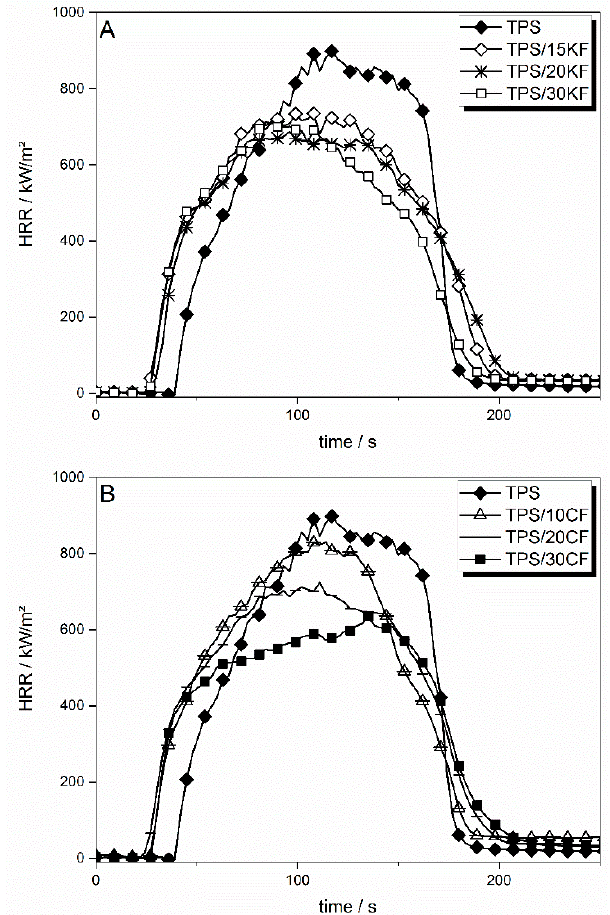
Figure 11. HRR curves for TPS reinforced with different amounts of keratin ( A ) and coconut fibres ( B ) in comparison to neat TPS.